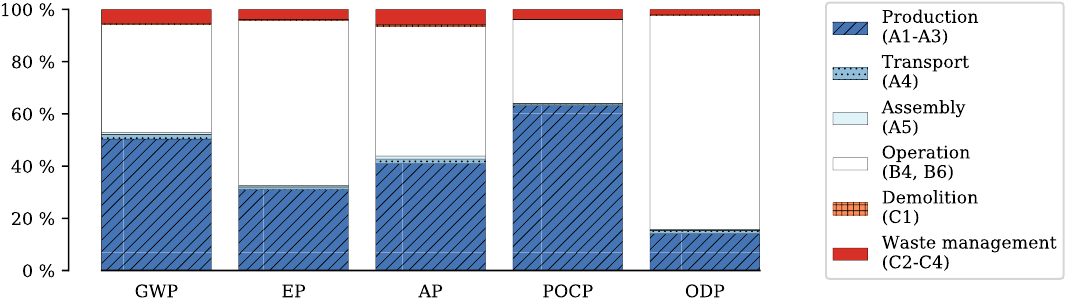
Figure 2. Normalised results for the whole building for each of the impact categories